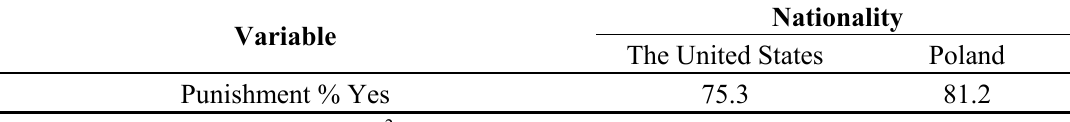
Table 4. Cross-tabulations of nationality and attitudes toward punishment (N =